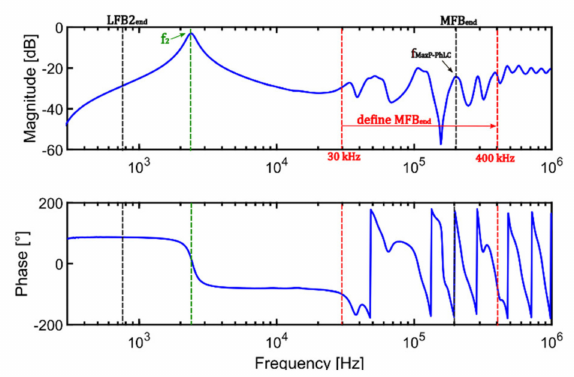
Figure 12. An example of class 2 FRA plot for identification of the MFB end .